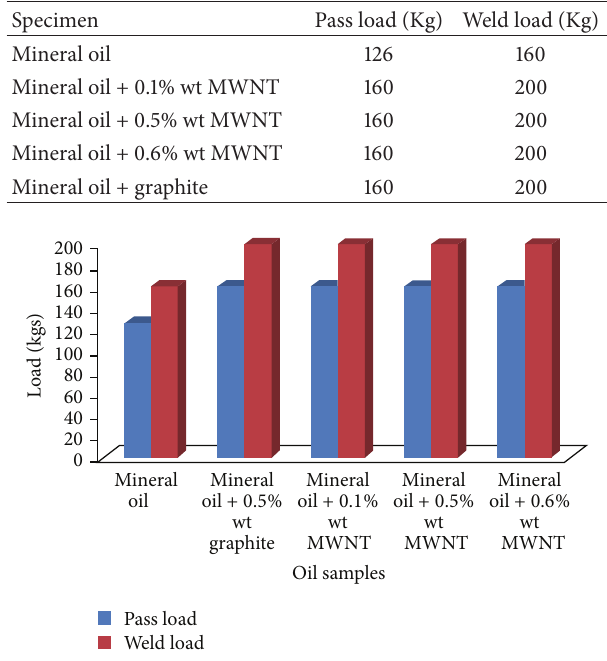
Figure 3: Pass load and weld load values from the four-ball test